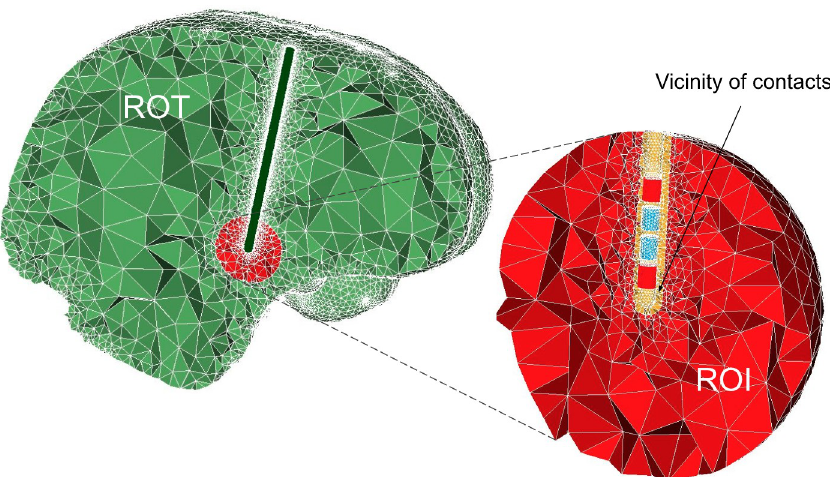
Fig 2. Example of an initial human brain discretization in OSS-DBS. The model is divided into the region of interest (ROI), the vicinity of contacts and the rest of the tissue (ROT). All three have their own submeshes with different element size requirements. Additionally, submeshes are defined for the electrode contacts and the encapsulation layer away from them. Controlled surface refinement of the contacts leads to a highly dense submesh around the electrode. Here, the active contacts are depicted in red, while the floating conductors are presented as blue cylinders.